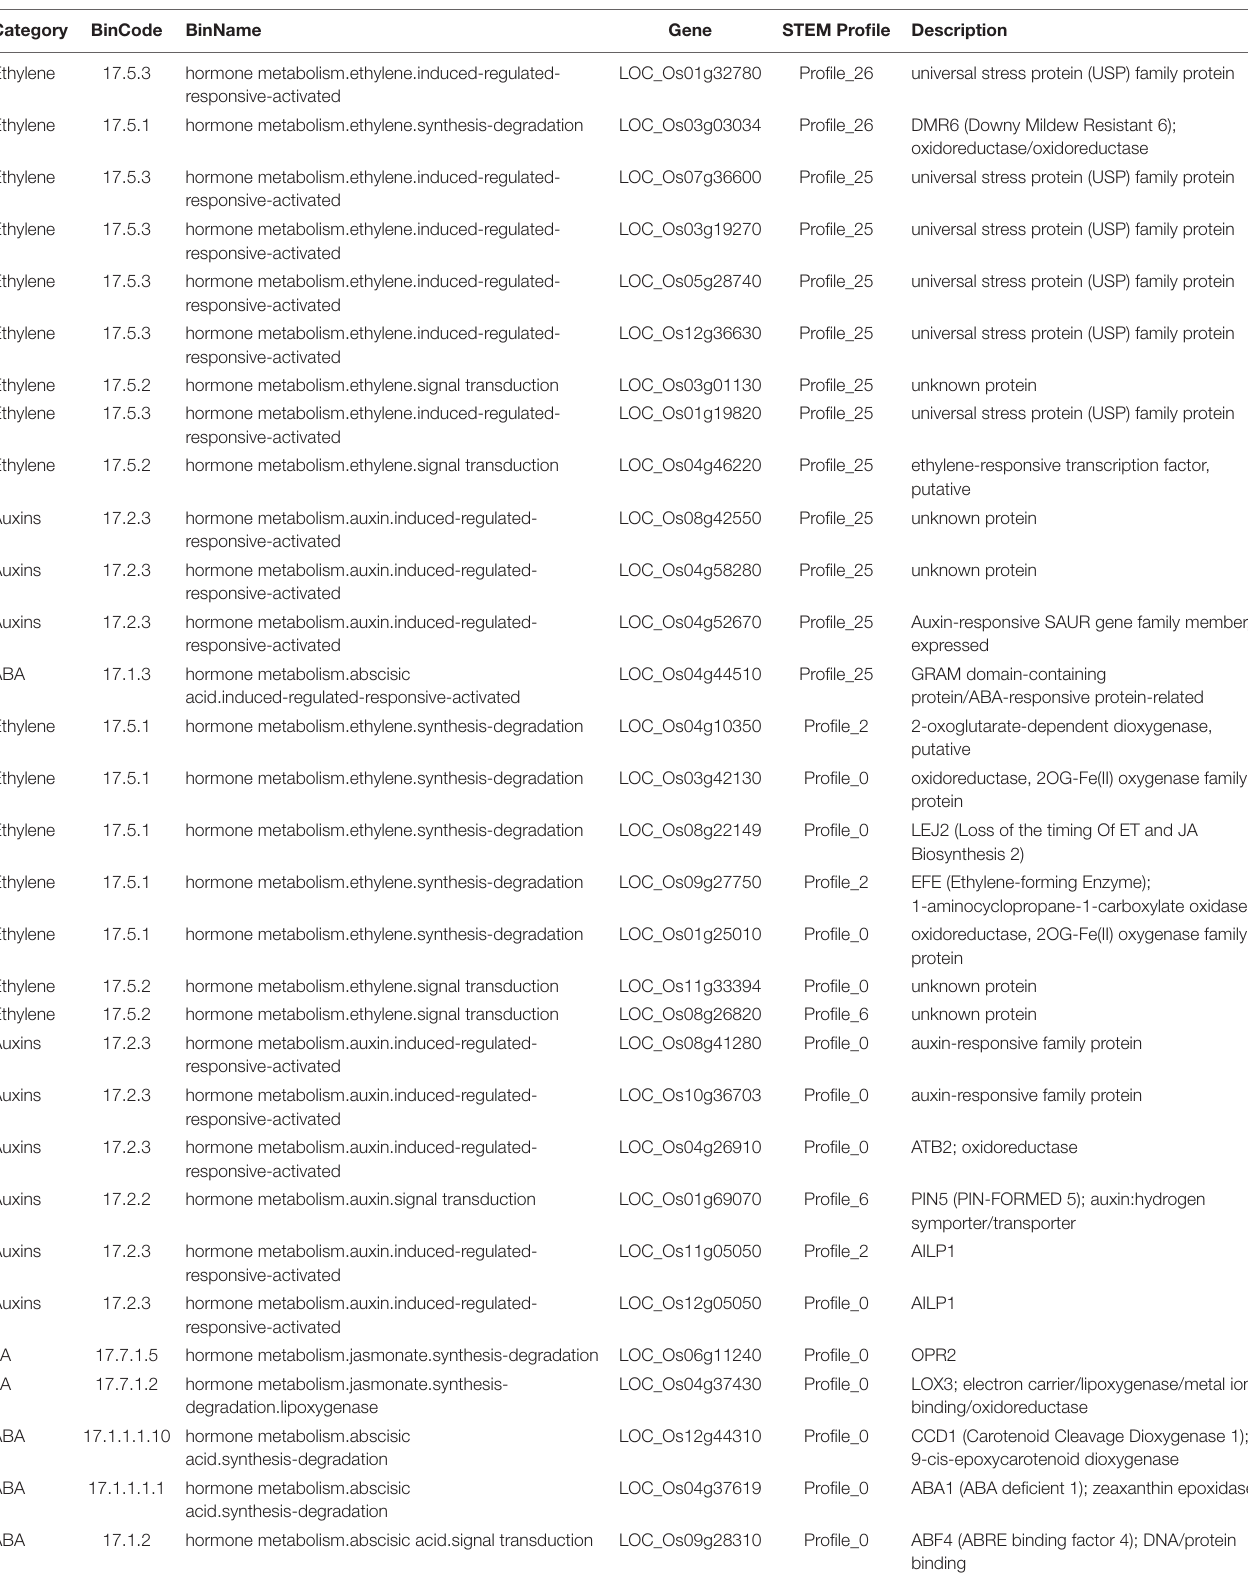
TABLE 2 | Assignment of O. sativa CDEGs in plant hormone pathways according to MapMan. Category BinCode BinName Gene STEM Profile